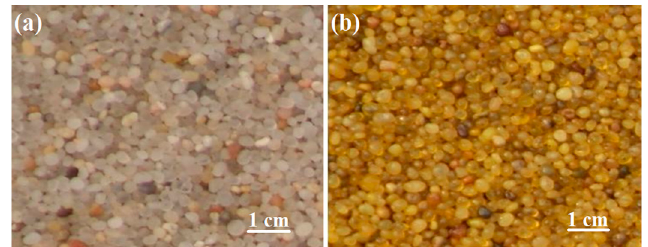
Figure 5. Sand ( a ) and coated sand ( b ) proppant. Table 4. Properties of polymer coated natural sand proppant.